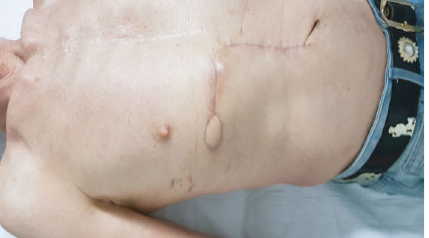
Figure 7: Postoperative picture at 9 months showing stable conditions. Further surgery to remove the skin island was o ff